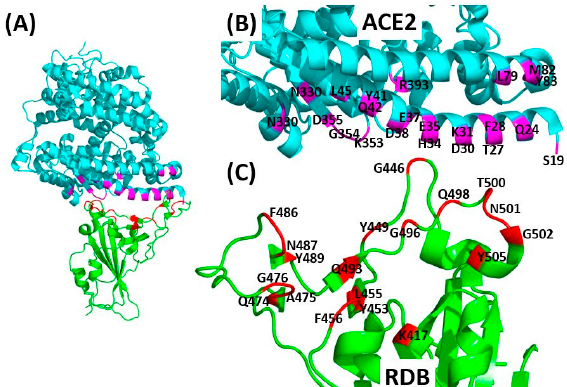
Figure 3. SARS ‐ CoV ‐ 2 spike protein. ( A ) The 3D structure of the SARS ‐ CoV ‐ 2 trimeric spike protein colored by its monomers. ( B ) Magnified visualization of the secondary structure of the SARS ‐ CoV ‐ 2 spike RBD where Beta sheets are labelled and colored in magenta, alpha helices are colored in cyan and loops are colored in pink. The RBM which directly interacts with ACE2 is colored in gray and its beta sheets are labelled. This figure was generated using PyMOL (Version 2) from the PDB: 6VSB for ( A ) and PDB: 6M0J for ( B ).